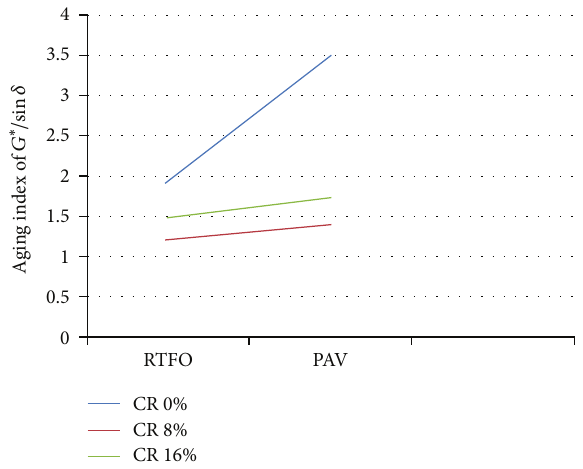
Figure 7: Aging index of 𝐺 ∗ / sin 𝛿 of bitumen binder versus CRM content.